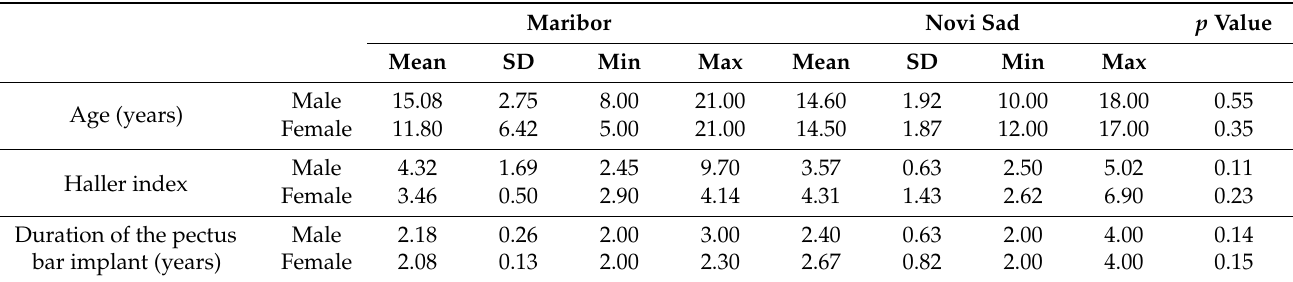
Table 2. Frequency values for age, the CT Haller index and duration of the pectus bar implant for each gender in Maribor and Novi Sad.